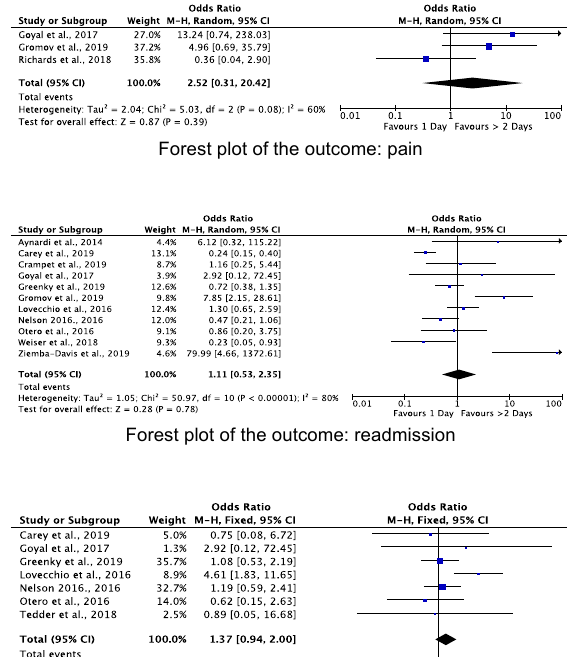
Forest plot of the outcome: revision Figure 3. Forest